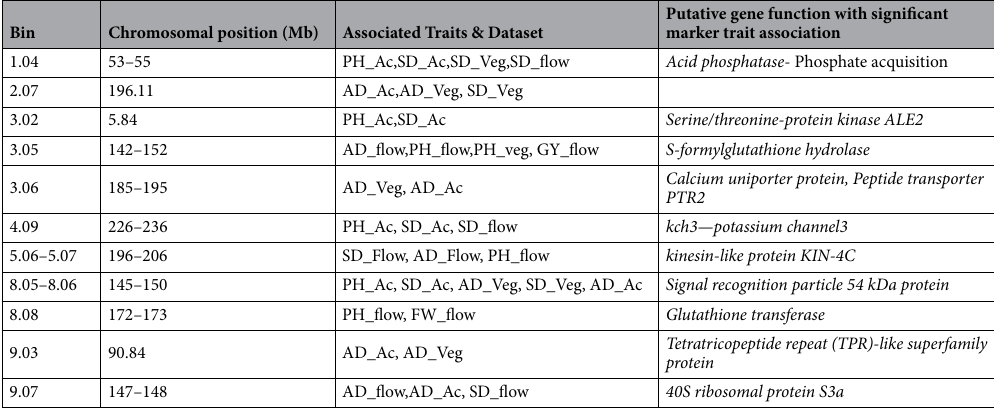
Table 5. Chromosomal regions with significant SNPs ( P value < 0.5 × 10 –5 ) associated with multiple traits across locations and their potential gene functions. GER, PH, GY, AD, SD, ASI represents percent germination; plant height, grain yield, days to 50% anthesis, days to 50% Silking and Anthesis-silking interval respectively and veg, flow and Ac represents the vegetative stage, flowering stage and across location dataset.